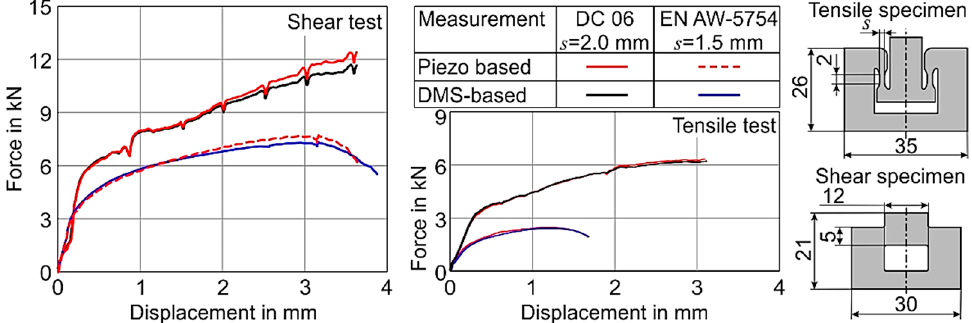
Figure 12. Quasi-static testing of the load measurement system, which also serves for calibration of the Youngs-modulus of the measurement body made of C45E.